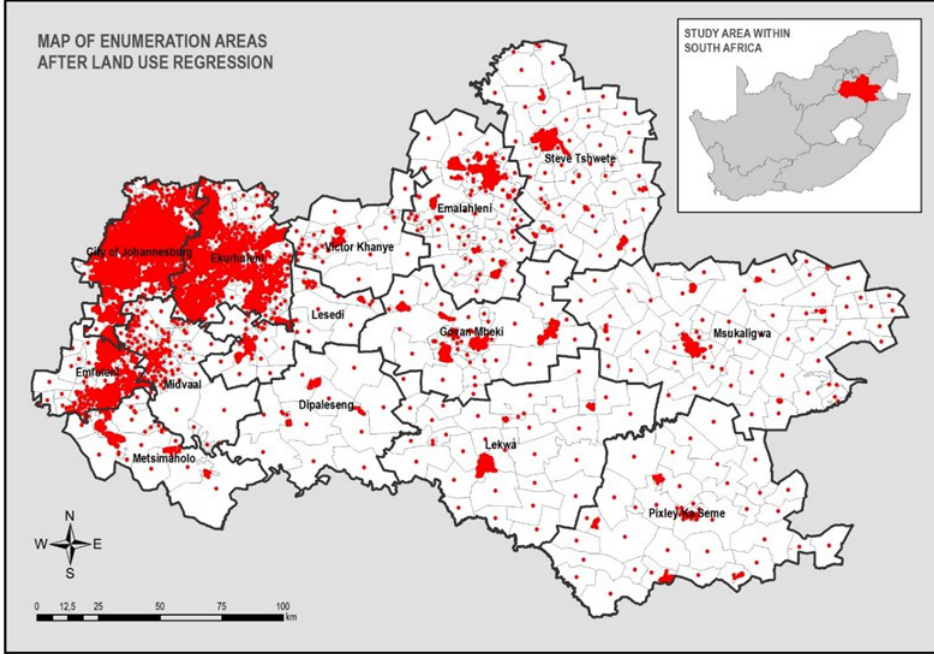
Figure 2. Map of numeration areas after land use regression.